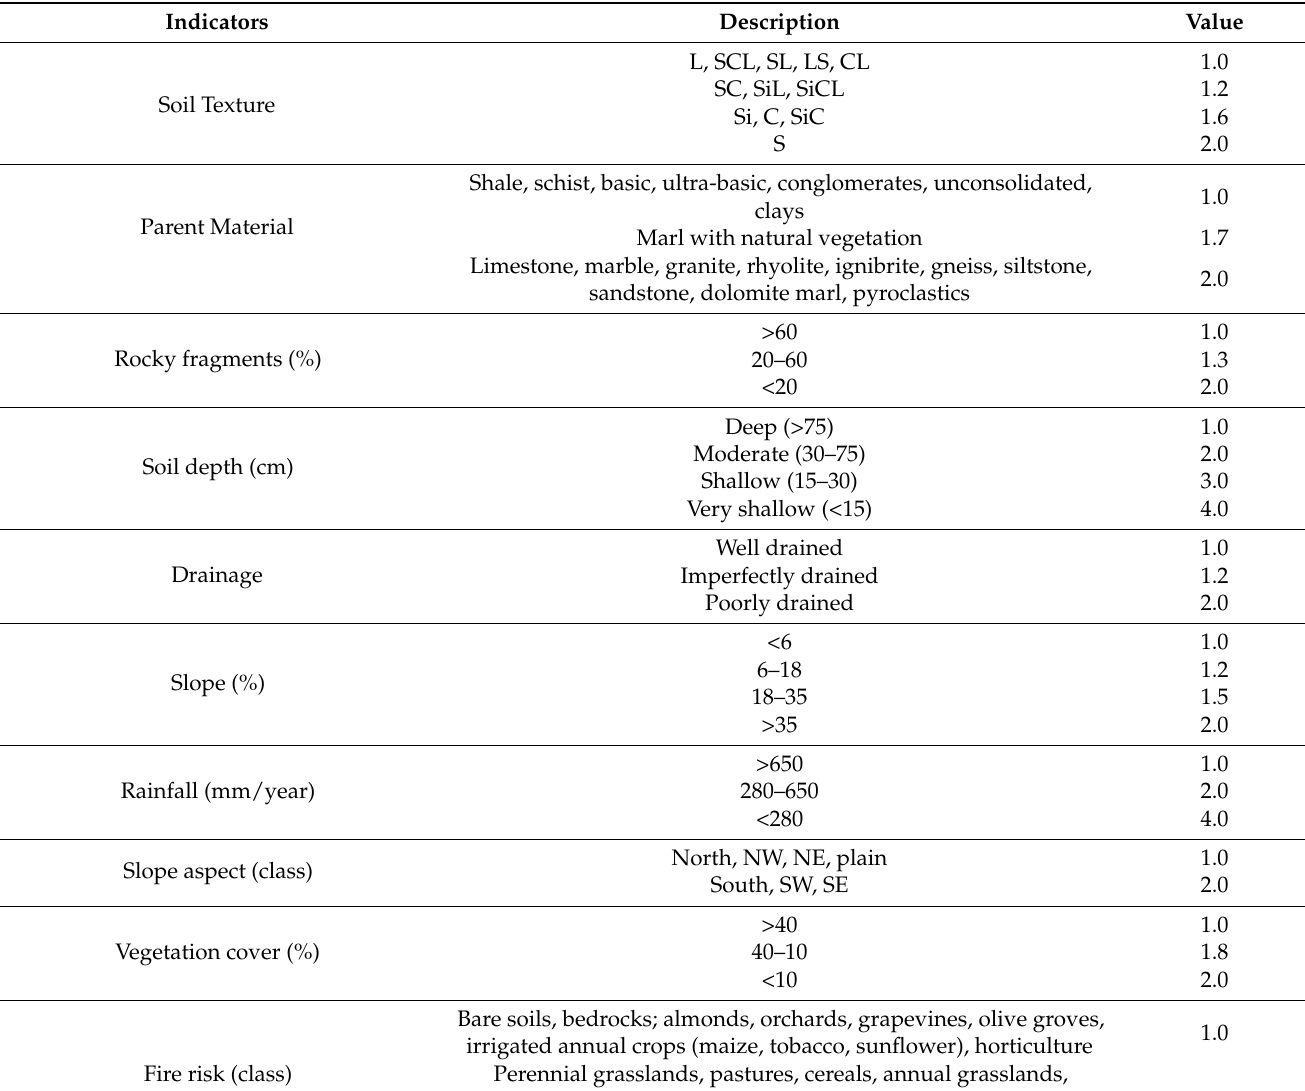
Table 1. Input Indicators with description and the related values